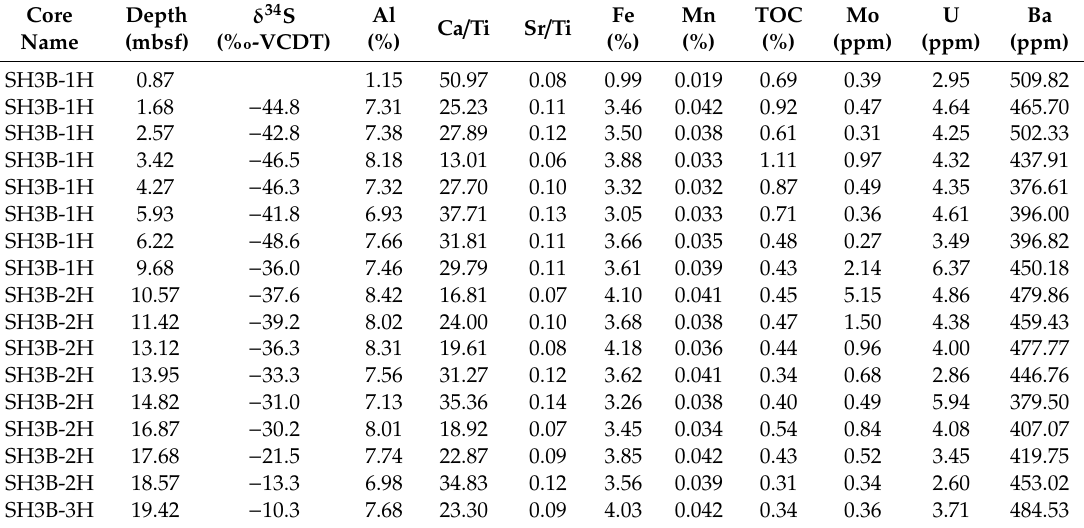
Table A1. Major and trace element contents in the sediments of core